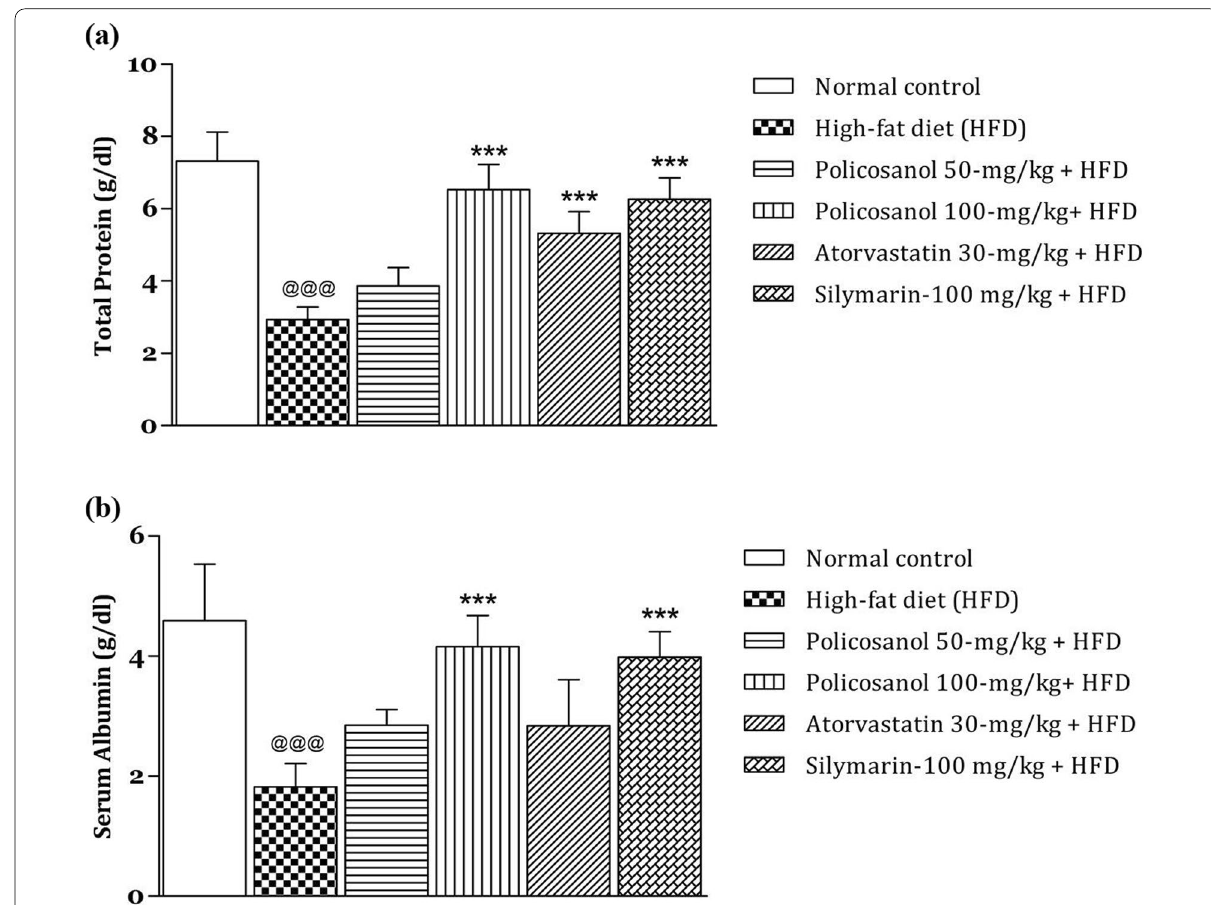
Fig. 1 Effect of Policosanol, Atorvastatin, and Silymarin treatments on serum. a Total protein, b Albumin in HFD-fed animals. All values are represented as mean SD ( n 6). @@@ p < 0.001 as compared with normal control animals; *** p < 0.001 as compared with HFD ± =